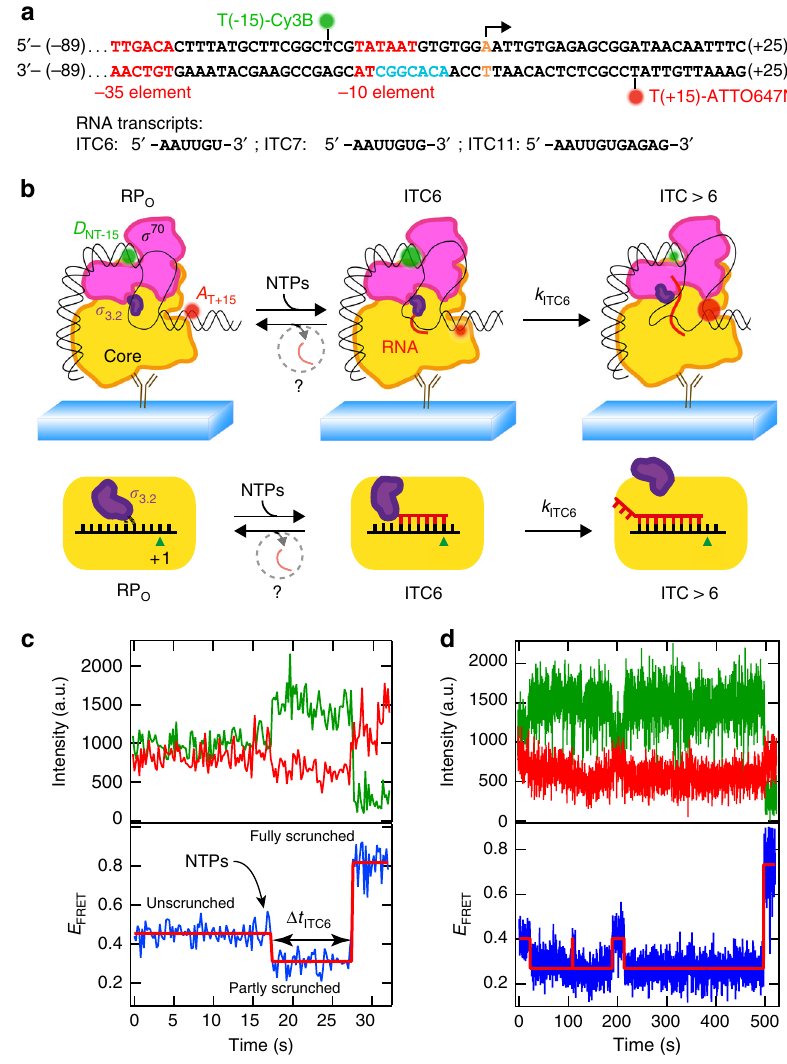
Fig. 1 Initial transcription monitored at the single-molecule level. a Representation of the premelted (turquoise font) WT DNA promoter used in the single- molecule experiments (Supplementary Fig. 1a). The – 35 and – 10 elements are represented in red. The promoter was donor labeled at – 15 position (green sphere) of the non-template DNA strand and acceptor labeled in + 15 (red sphere) position of the template DNA strand. An arrow above the base in orange font indicates the + 1 position. All the promoters used in the study are described in Supplementary Fig. 1a. b Schematic of the initial transcription experiment (Methods). Above: using TIRFM-based smFRET, we monitored the E FRET variations of the donor – acceptor pair upon NTP addition. The RNAP fl uctuates between RP O , ITC6, and ITC > 6, to eventually escape the initiation phase toward the elongation phase, or to release the nascent RNA; below: cartoon that magni fi es the interactions between the 5 ′ -RNA end and σ 3.2 and the position of the 5 ′ -RNA end. c Fluctuations in the donor (green) and acceptor (red) dyes intensities (above) and the resulting E FRET (below, blue), showing the variation of E FRET from an Unscrunched (US) FRET state, followed by the Partly Scrunched (PS) FRET state upon NTP addition, and ending in the Fully Scrunched (FS) FRET state. Experimental conditions: 200 ms time points (100 ms ALEX, Methods), 500 µ M ApA, and 80 µ M All NTP. d Similar experiment conducted as described in c , with the RP failing multiple times before reaching the FS FRET state. Experimental conditions: 200 ms time points, 500 µ M ApA, and 30 µ M of all NTPs and WT promoter. The red solid lines in the lower panels in c and d represent the FRET states extracted from hidden Markov modeling (HMM)